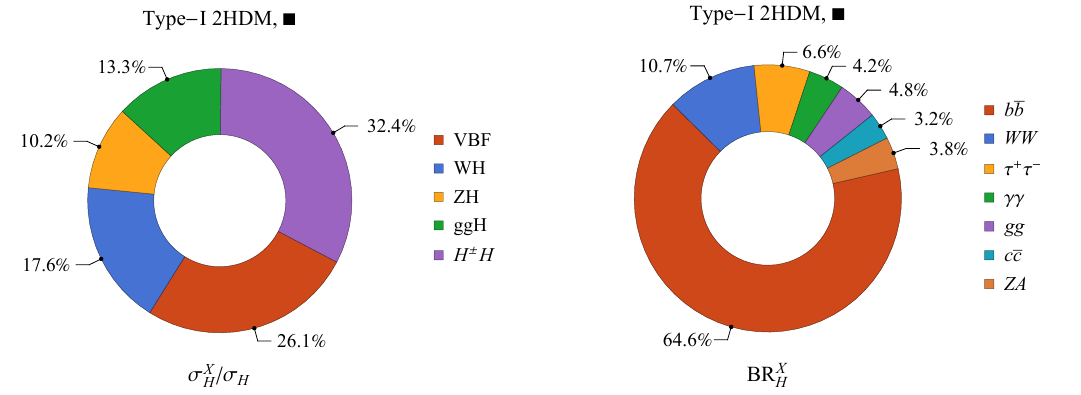
Figure 14 . As (cid:12)gure 2 but for the fourth type-I 2HDM benchmark scenario (3.4). The label \ H (cid:6) H " in the left panel refers to associated H production via pp ! W (cid:6)(cid:3) ! H (cid:6) H . Only values of BR X that are larger than 2% are explicitly H